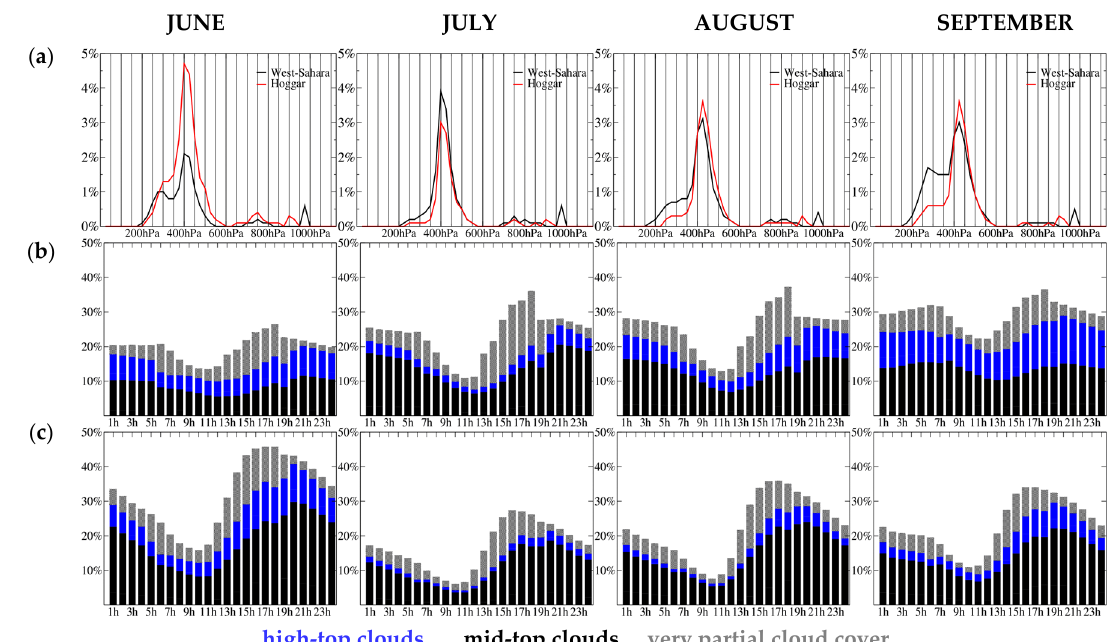
Figure 5. ( a ) Cloud top pressure occurrence frequency distributions for West-Sahara (black line) and Hoggar (red line). ( b ) for West-Sahara and ( c ) Hoggar, the diurnal evolution of the COF at 15 ′ time step averaged over one hour.